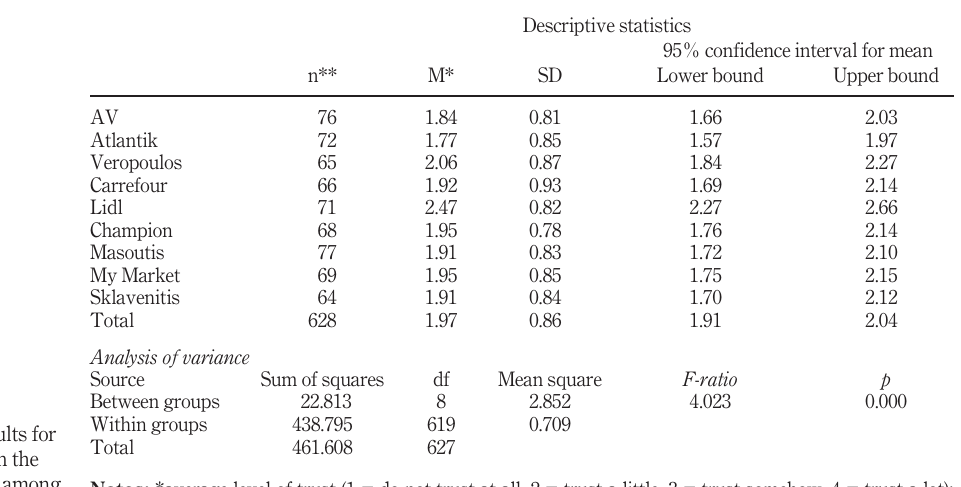
Table V. ANOVA results for similarities in the level of trust